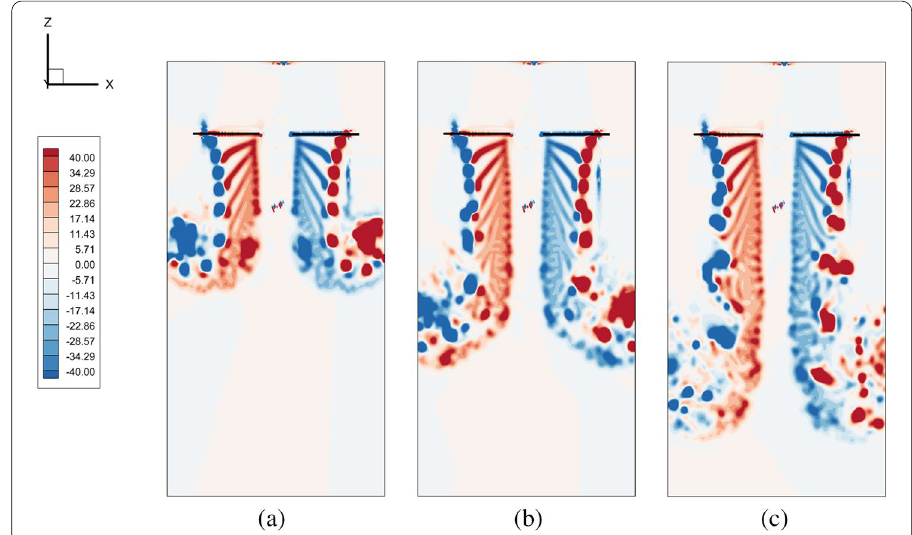
Fig. 8 Rotor vorticity structures: ( a ) 10 rev., ( b ) 15 rev., and ( c ) 20 rev